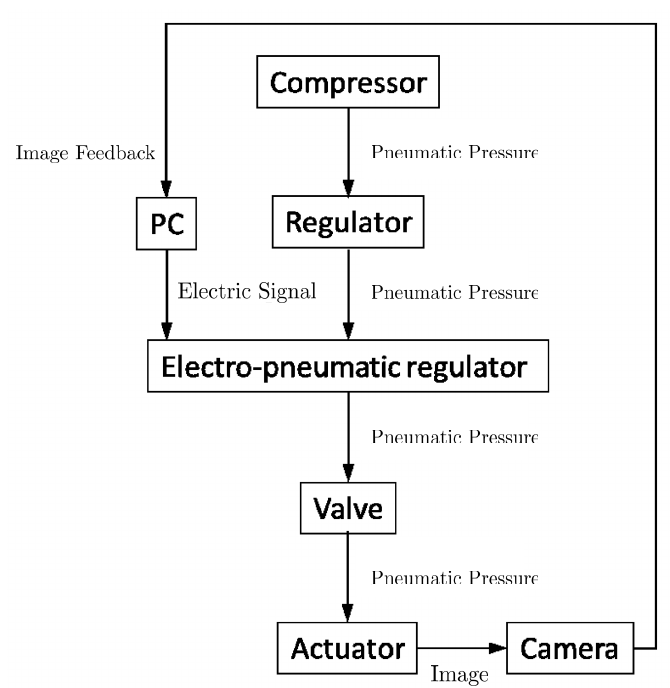
Figure 8. Experimental system.